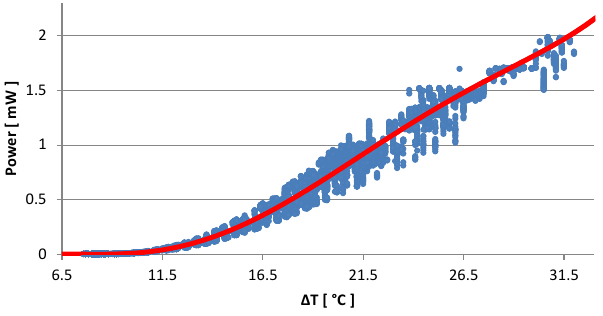
Figure 3. Generated output power (in Watts) versus Thermal gradient (in Celsius degrees).